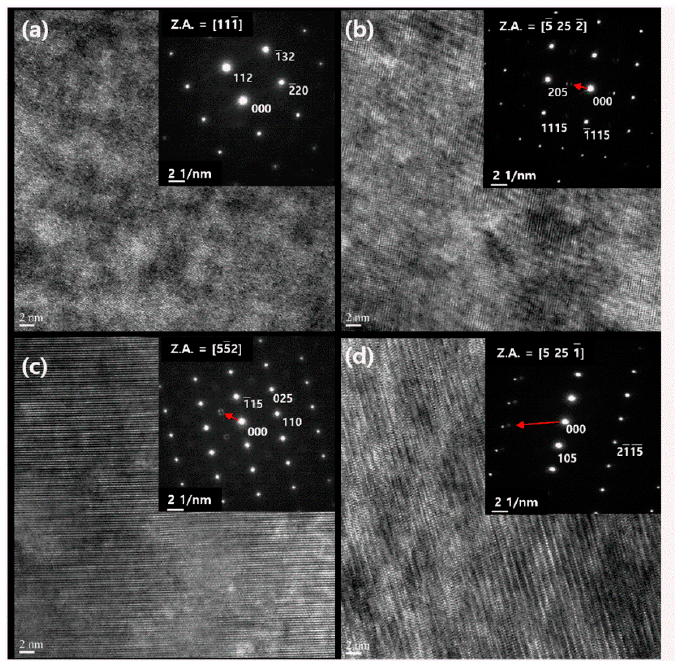
Figure 5. High-resolution transmission electron microscopy (HR-TEM) images and electron diffraction patterns (inset) of Bi 2 Te 2.85 Se 0.15 I x compounds of x = ( a ) 0.0, ( b ) 0.1, ( c ) 0.3 and ( d ) 0.5 mol.%.